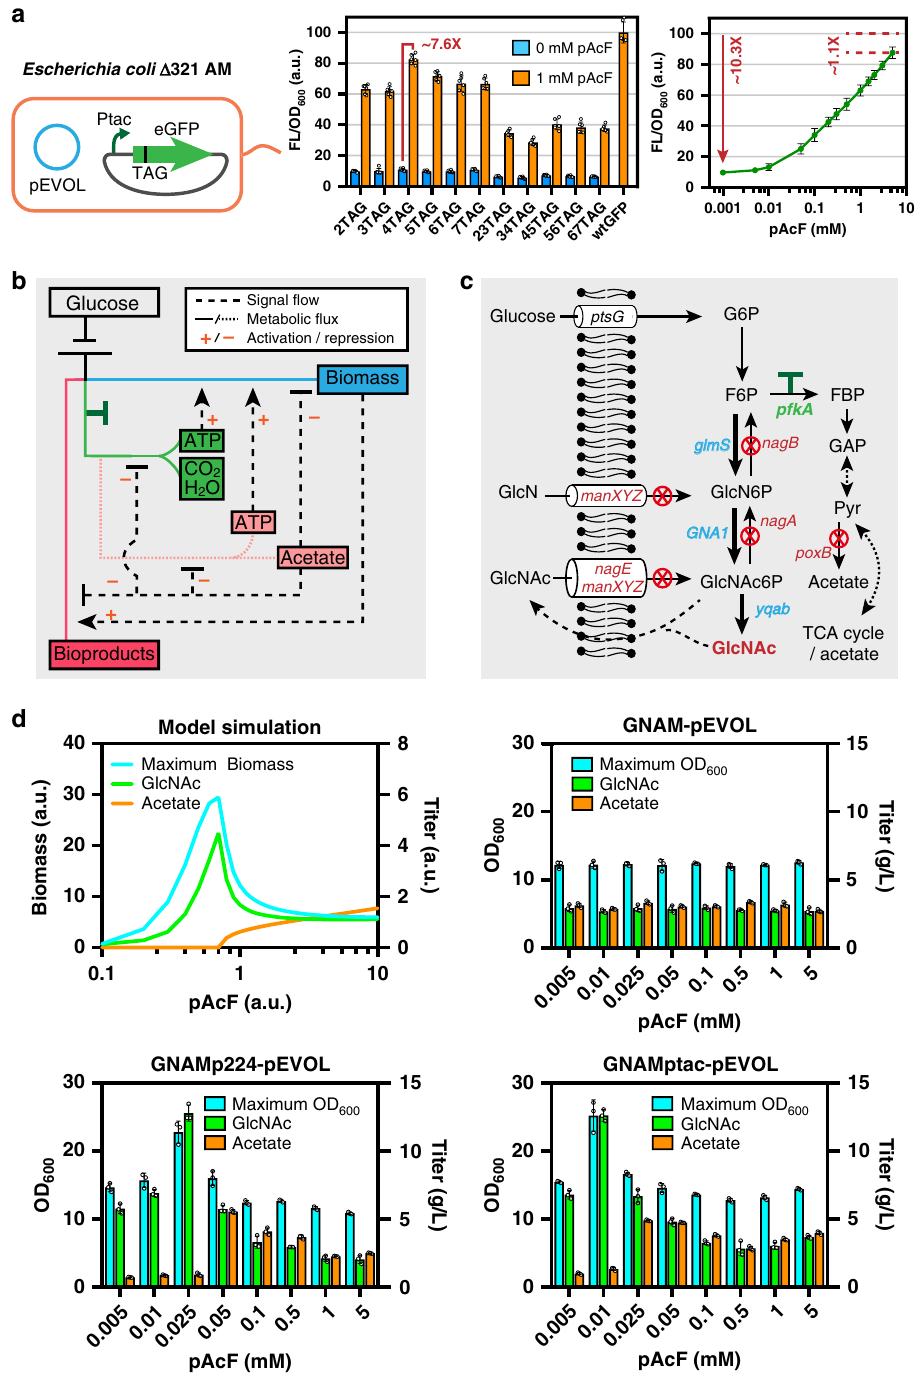
Fig. 2 Non-canonical amino acid (ncAA) incorporation tool-based pathway regulation in genetically recoded Escherichia coli Δ 321AM. a Testing the ef fi ciency of ncAA tool-pEVOL using the reporter protein GFP (left panel). The histogram (middle panel) represents the degree of GFP expression recovery after replacing one or two original codons by amber stop codons in the sequence from the second to the seventh codon (2TAG to 7TAG and 23TAG to 67TAG). The data are expressed as the mean ± SD from six ( n = 6) biologically independent replicates. The line graph (right panel) shows the use of the 2TAG GFP gene to test GFP expression levels in the presence of different concentrations of p -acetyl-L-phenylalanine (pAcF). The data are expressed as the mean ± SD from three ( n = 3) biologically independent replicates. b Intracellular metabolic feedback loop of engineered E. coli . ‘ T ’ marker represents the regulation of metabolic fl ow. c Construction of the N -acetylglucosamine (GlcNAc) biosynthetic E. coli Δ 321AM strain. Red circular symbols represent gene knockouts, the ‘ T ’ marker represents the regulation of metabolic fl ux, and bold arrows represent an increase in metabolic fl ux. d Model simulated (half- saturation constant K S = 15) and actual fermentation results of the three GlcNAc biosynthetic strains measured in the presence of different pAcF concentrations. The data are expressed as the mean ± SD from three ( n = 3) biologically independent replicates. Source data underlying ( a ), ( d ) are provided as a Source data fi